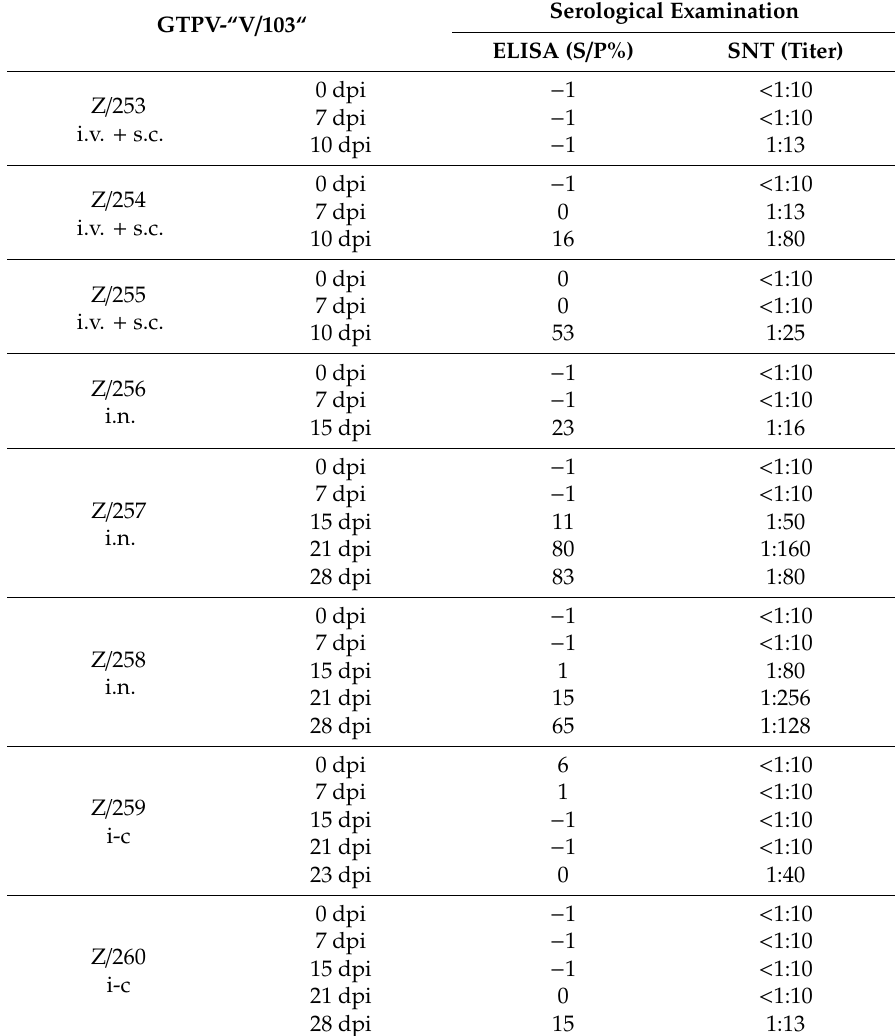
Table 5. Serological analyses of serum samples taken from goats inoculated with GTPV-“V / 103“. For the ELISA, an S / P% of ≥ 30 was defined as positive. In the SNT, a titer ≥ 1:20 is defined positive. Serological GTPV-“V / 103“